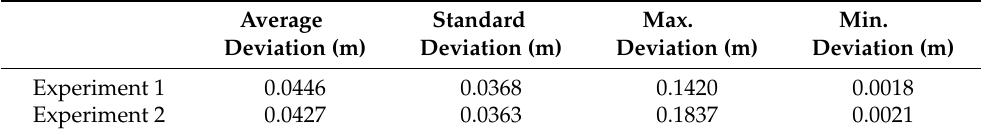
Table 4. Robot’s deviation from the planned